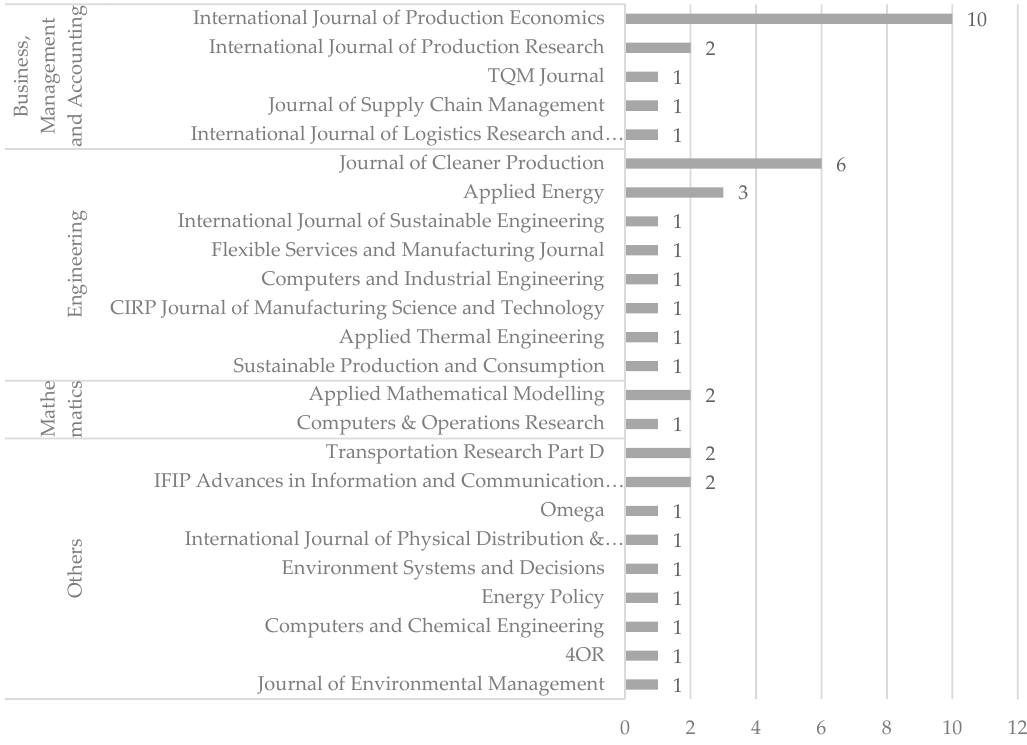
Figure 6. Number of sampled articles per journal.